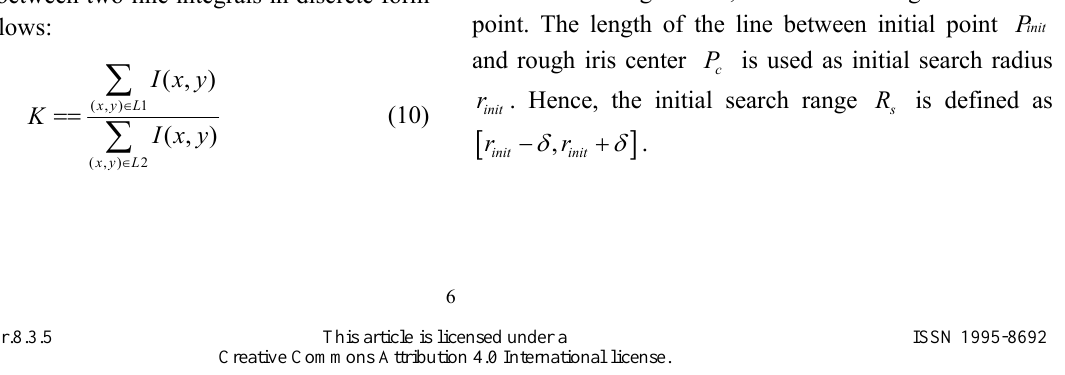
point. The length of the line between initial point and rough iris